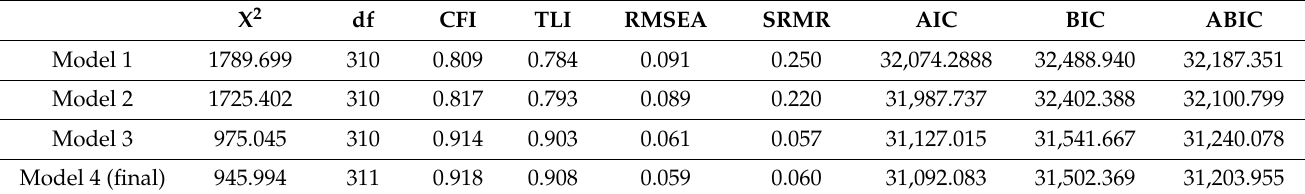
Figure 2. The hypothesized Model 1 of the relationships among variables.